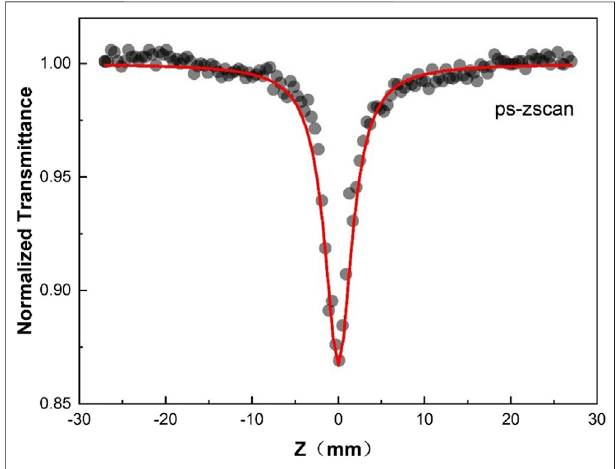
FIGURE 3 | 355 nm PS open-aperture Z-scan for Ga 2 O 3 : Sn bulk crystals. The solid lines are the numerical fi ts to the experimental